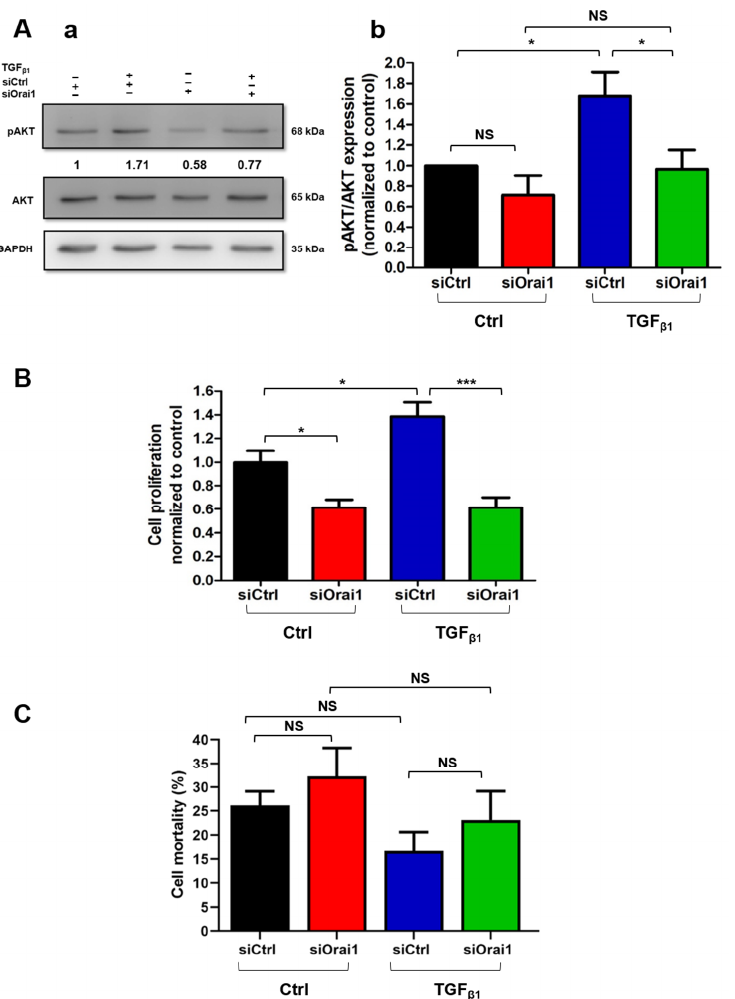
Figure 6. TGF β 1 promotes Orai1/AKT-dependent proliferation through an autocrine positive feed- back loop in human-activated PSCs. ( A ) TGF β 1 stimulation decreased AKT phosphorylation in Orai1 knocked-down cells. Orai1 knocked-down cells were FBS-starved overnight and then stimulated 30 min with TGF β 1, 72 h post-transfection. Representative Western blot of TGF β 1 stimulation on Orai1 knocked-down mediated AKT activation ( Aa ) and the quantification (* p < 0.05, at least N = 3, two-way ANOVA followed by Bonferroni post hoc test, ( Ab ). All values were first normalized to the referent protein GAPDH and then to siCtrl non-treated with TGF β 1 condition and reported as mean ± SEM. ( B , C ) Involvement of TGF β 1 in PS-1 cell proliferation and survival. Transfected cells were treated 48 h with TGF β 1 (20 ng/mL) within an FBS-free medium, and the proliferation rate, as well as the mortality rate, were evaluated by Trypan blue assay, 72 h post-transfection (* p < 0.05, *** p < 0.001, NS, N = 3, one-way ANOVA followed by Bonferroni multiple comparison tests). All values were normalized to siCtrl non-treated with TGF β 1 condition and reported as mean ± SEM. Cell mortality was calculated using the formula: % of cell death = number of dead cells/number of total cells, reported as mean ± SEM for each